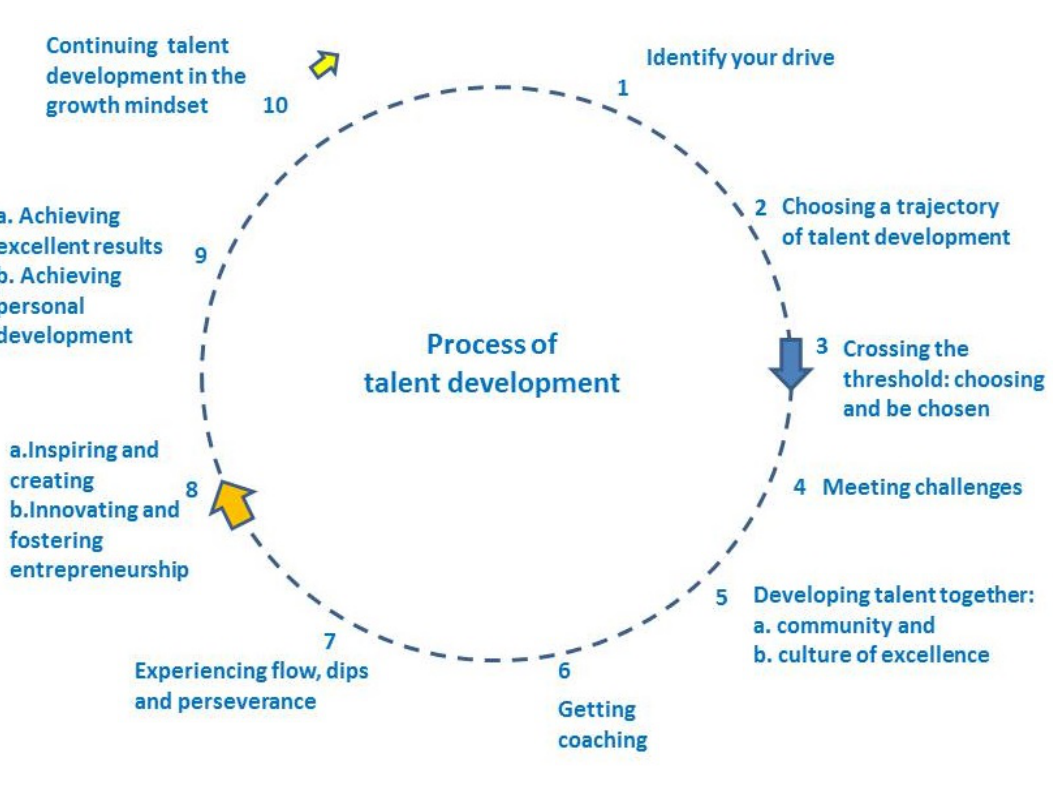
Figure 1: Circle of Talent Development